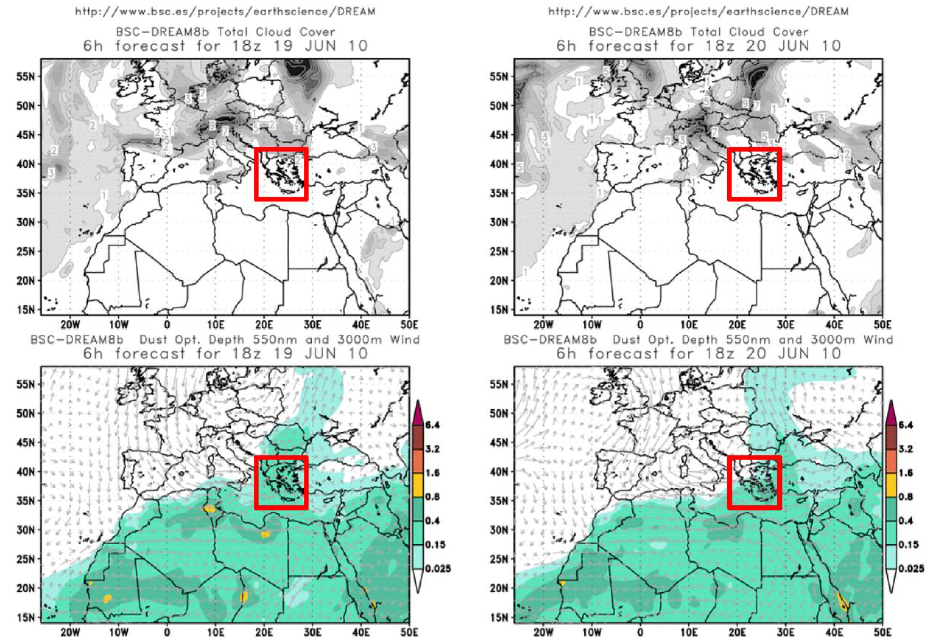
Fig. 6. Dust optical (AOD) depth at 550nm and 3000m wind fields over Greece for the 19 and 20 June 2010, as simulated by the BSC/DREAM model (18:00UTC). The greater area of Greece is indicated by a red-lined rectangle. The island of Hydra is on the cen- tre of this